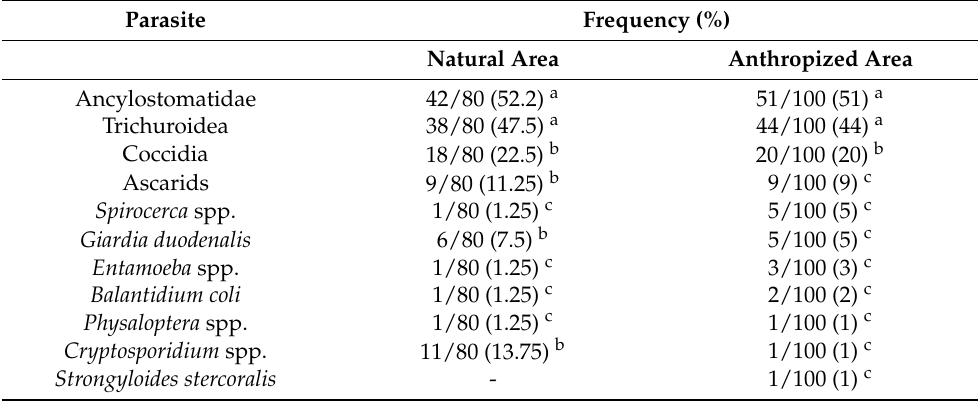
Table 2. Overall frequencies of parasites identified in wild canid fecal samples in the natural and anthropized area. Significant differences recorded for parasite occurrence within the natural and anthropized areas are indicated with different superscript